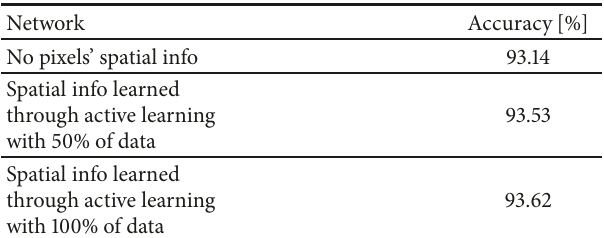
Table 3: Distraction classification results by training (AlexNet) and testing on skin segmented images.